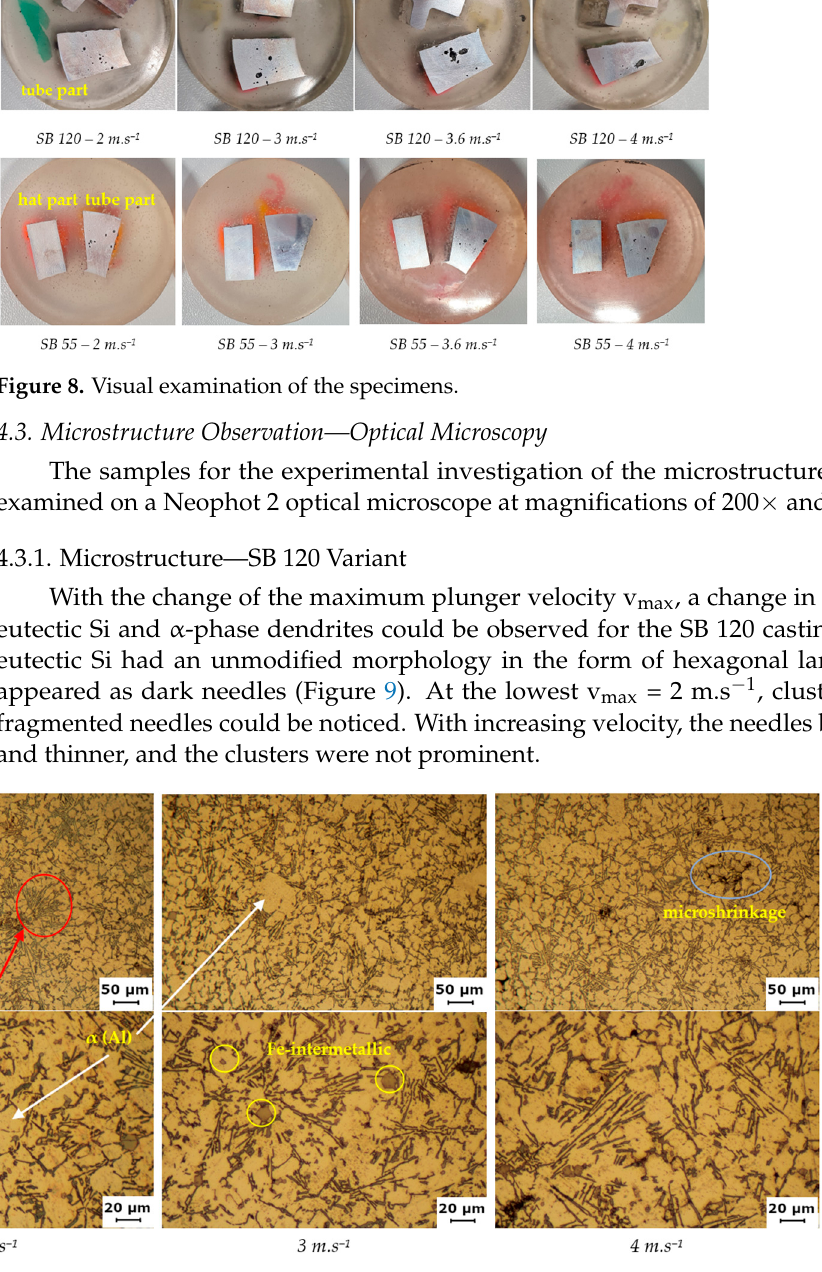
Figure 8. Visual examination of the specimens.